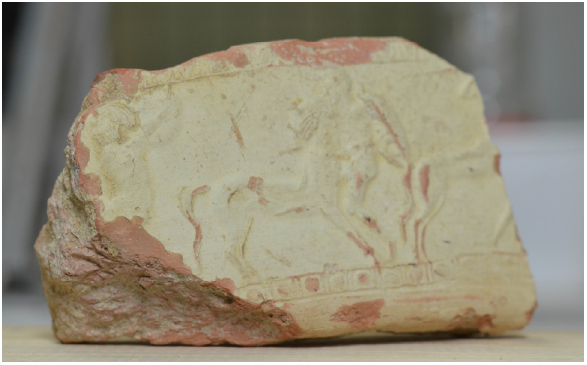
Figure 3. Potsherd decorated with Centauromachia